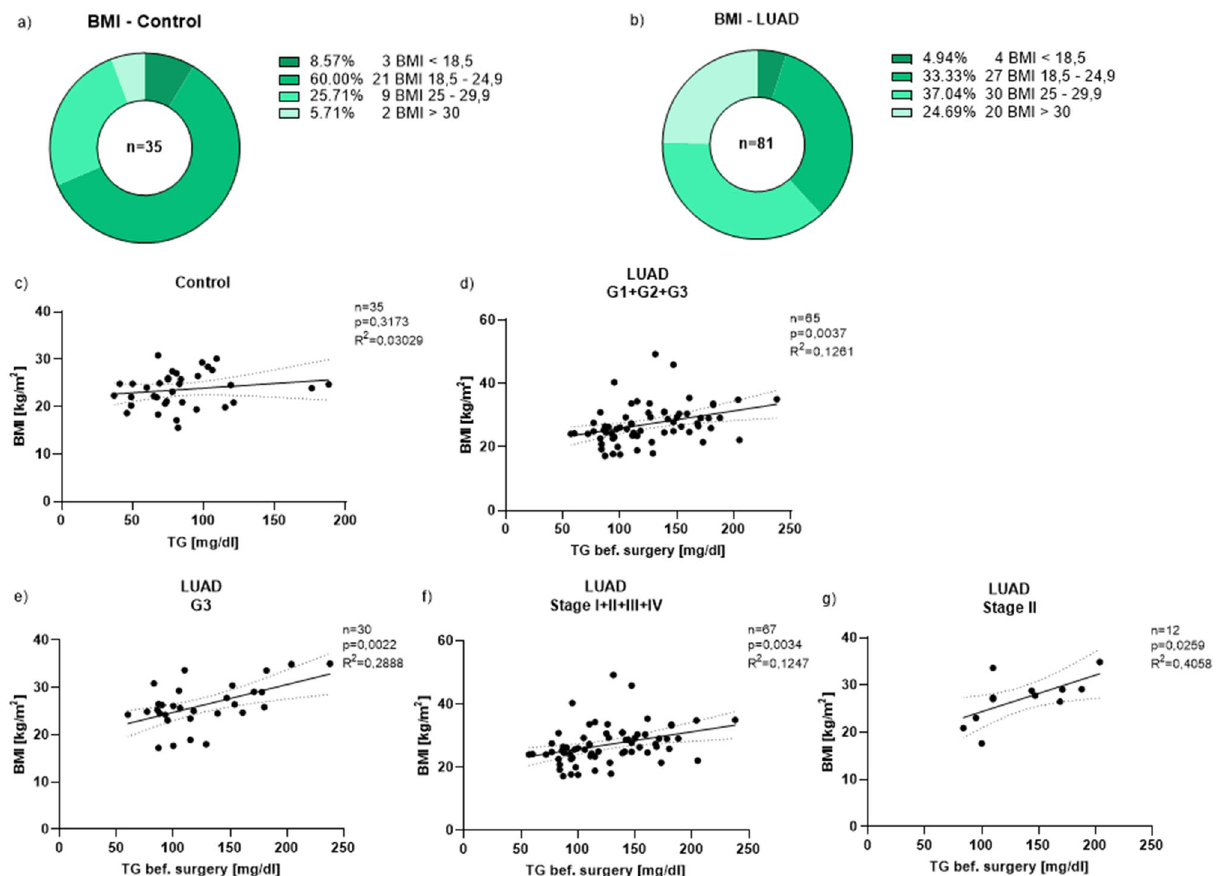
Figure 2. Pre-surgical triglyceride values directly correlate with the BMI in dependence of the grading/ the TNM classification. ( a ) Diagram of distribution of our control patients’ cohort depending on the BMI (BMI < 18.5 (underweight): n = 3; BMI 18.5–24.9 (normal weight): n = 21; BMI 25–29.9 (overweight): n = 9; BMI > / = 30 (obese): n = 2). ( b ) Diagram of distribution of our LUAD patients’ cohort depending on the BMI (BMI < 18.5 (underweight): n = 4; BMI 18.5–24.9 (normal weight): n = 27; BMI 25–29.9 (overweight): n = 30; BMI > / = 30 (obese): n = 20). ( c ) Direct correlation between the triglyceride values and the BMI of all control patients (n = 35, p = 0.3173, R 2 = 0.03029). ( d ) Direct correlation between the triglyceride values before surgery and the BMI of all LUAD patients (G1 + G2 + G3) in dependence of the grading (n = 65, p = 0.0037, R 2 = 0.1261). ( e ) Direct correlation between the triglyceride values before surgery and the BMI of all LUAD patients with G3 in dependence of the grading (n = 30, p = 0.0022, R 2 = 0.2888). ( f ) Direct correlation between the triglyceride values before surgery and the BMI of all LUAD patients (Stage I + II + III + IV) in dependence of the TNM classification (n = 67, p = 0.0034, R 2 = 0.1247). ( g ) Direct correlation between the triglyceride values before surgery and the BMI of all LUAD patients with Stage II in dependence of the TNM classification (n = 12, p = 0.0259, R 2 = 0.4058). Correlations are shown by using simple linear influence each other, especially in dependence of the grading and the TNM classification. Therefore, we first took a closer look at the triglyceride values that were measured before surgery depending on the grading. It became apparent that the mean triglyceride value of the tumor patients in all three subgroups (G1, G2 and G3) was still within the normal reference range of under 150 mg/dl (G1: 146.2 mg/dl; G2: 121.4 mg/dl; G3: 125 mg/dl) (Sup- plementary Fig. S2a). However, it was higher than in the control patients’ group (Control: 87.2 mg/dl). Look- ing at the higher triglyceride value of each patient separately, there are way more tumor patients (n = 16) with triglyceride values above 150 mg/dl in comparison to the control patients (n = 2) (Supplementary Fig. S2a,b). To assess whether triglyceride values in the blood are influenced by the BMI of patients, we then correlated the triglyceride values of all control subjects and patients with G1, G2 and G3 tumor tissue with the BMI and found a significant correlation between these two parameters in patients with LUAD but not in control subjects (Fig. 2c,d). Looking at the grading subgroups individually, especially the LUAD patients with G3 tissue showed a direct significant correlation between the pre-surgical triglyceride values and their BMI (Fig. 2e). After having taken the tumor grading into consideration, we then looked at the TNM classification and how the triglyceride values are dependent on it. We observed that similar to Supplementary Fig. S2a the patients’ triglyceride values were in average higher than in the control group (Stage I: 143.4 mg/dl; Stage II: 136 mg/dl; Stage III: 102.8 mg/dl; Stage IV: 129.6 mg/dl; control group: 87.2 mg/dl) (Supplementary Fig. S2b). When correlating the triglycerides of all tumor patients (Stage I, II, III and IV) with the BMI there was a direct significant correlation again (Fig. 2f).